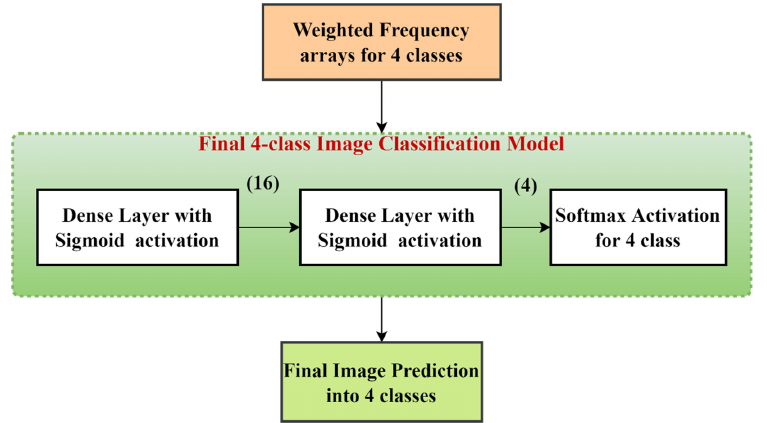
Figure 9. Image classification model using patch-prediction probabilities.